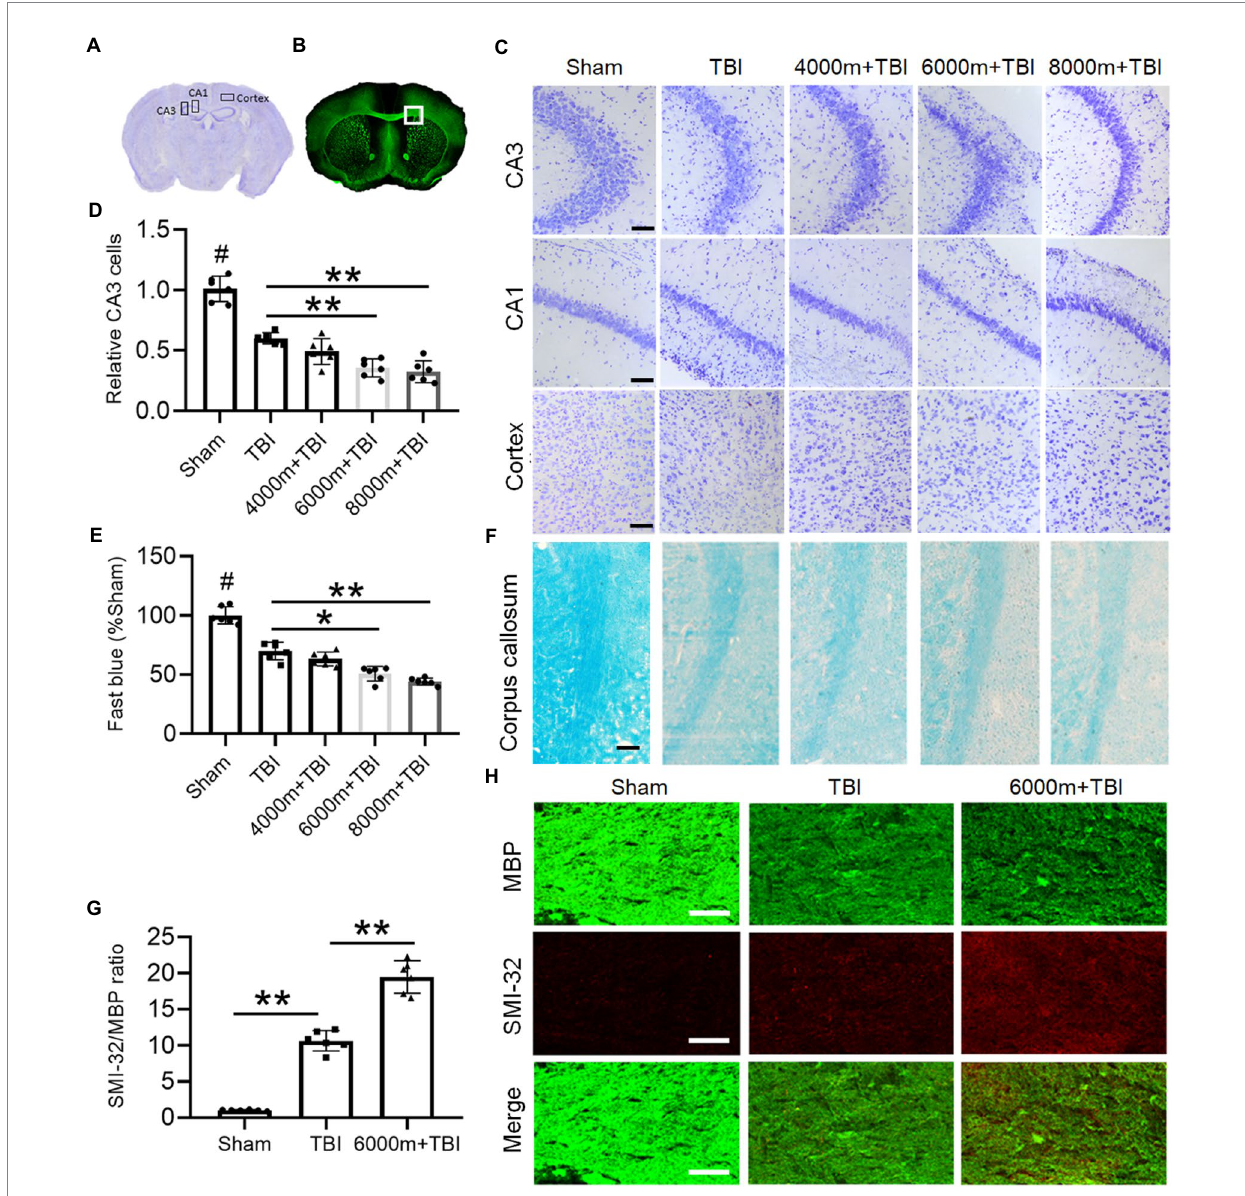
FIGURE 2 Effects of different altitudes on the degree of cerebral gray and white matter damage following TBI. (A) The regions of interest are CA3 and CA1 in the hippocampus and cortex of Nissl staining in a coronal section of the mouse brain. (B) The square region of interest is the corpus callosum (CC) area of MBP fluorescence staining in a coronal section of the mouse brain. (C) Nissl staining of the right side of CA3, CA1 and cortex in different groups, scale = 50 μ m. (D) Relative quantification of viable CA3 cells ( n = 6). (E) The integrated density of Luxol fast blue staining and normalized to sham animals ( n = 6). (F) Representative fast blue staining of the CC, scale = 50 μ m. (G) The degree of white matter injury was expressed as the ratio of SMI-32 to MBP ( n = 6). (H) Double immunofluorescent staining for SMI-32 and MBP in the right CC, scale = 50 μ m. * p < 0.05, ** p < 0.01 versus the indicated group; # p < 0.01 versus other